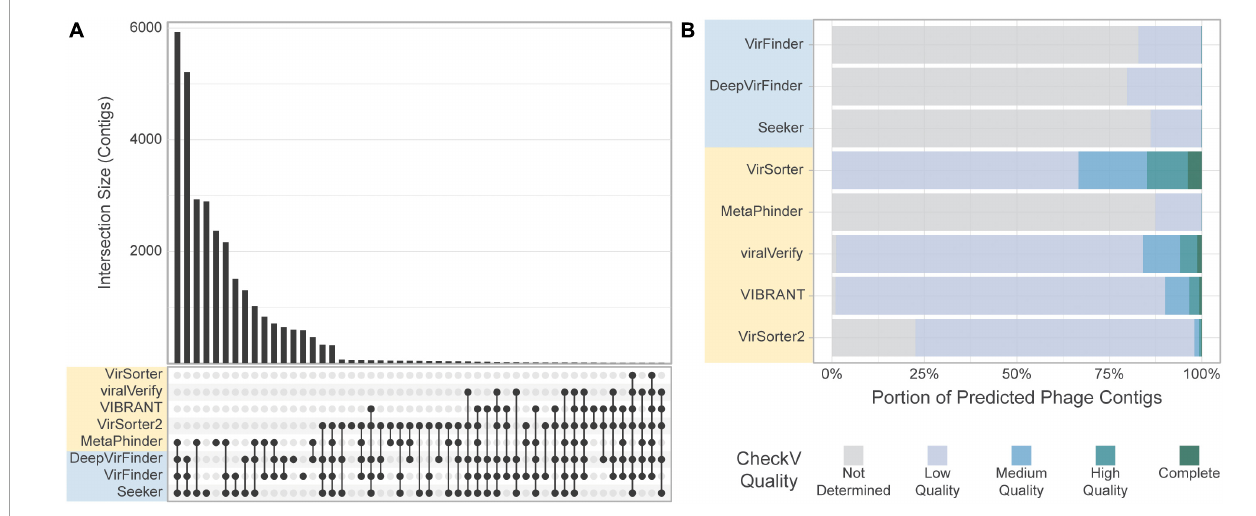
FIGURE9 Comparison of the tools’ classification on real-world viromes. (A) Upset plot showing intersection size, with the x -axis in order of decreasing set size, top 51 intersections shown. (B) CheckV assessment of predicted phage contigs from the Gut Virome dataset. Predicted phage contigs from each tool are categorized by CheckV, and plotted as a stacked bar chart of the portion of predicted phages in each